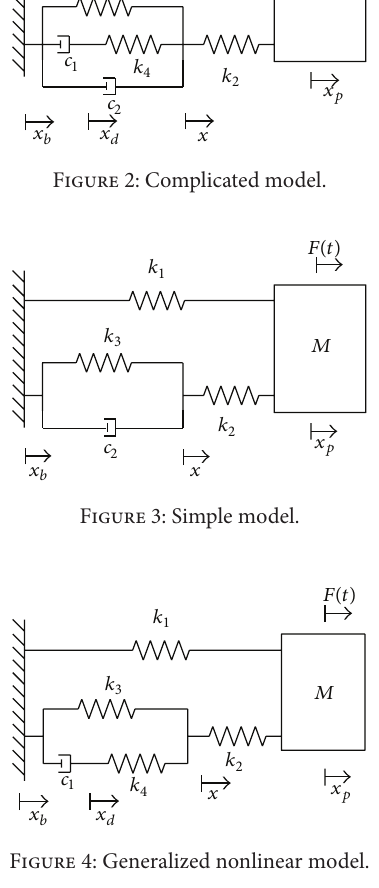
Figure 4: Generalized nonlinear